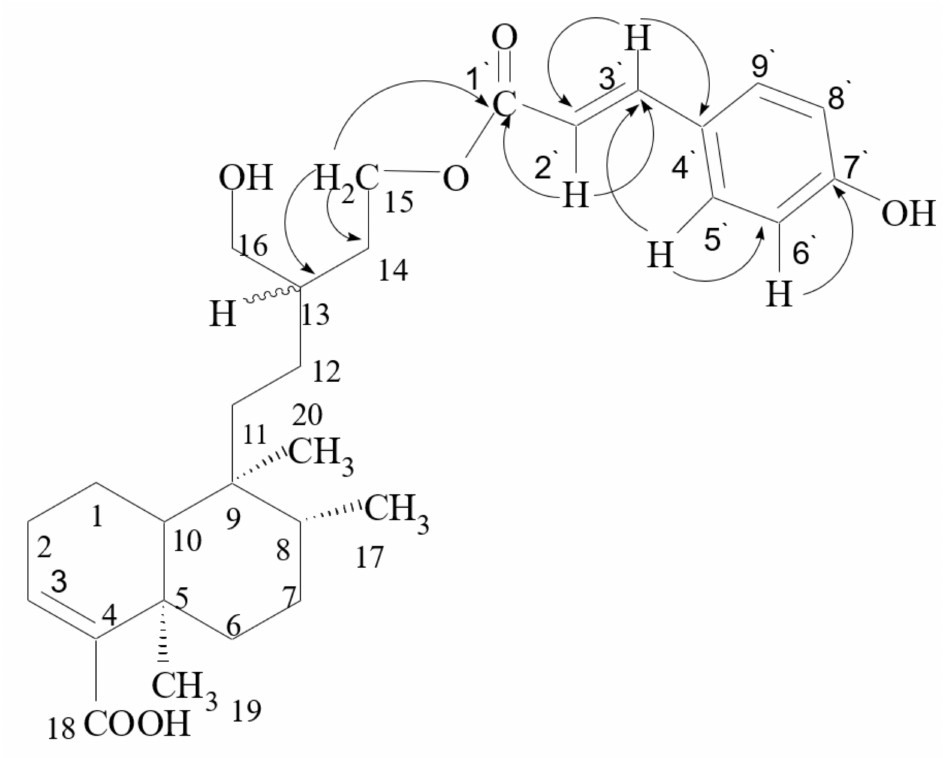
Figure 2. Important HMBC Correlations of